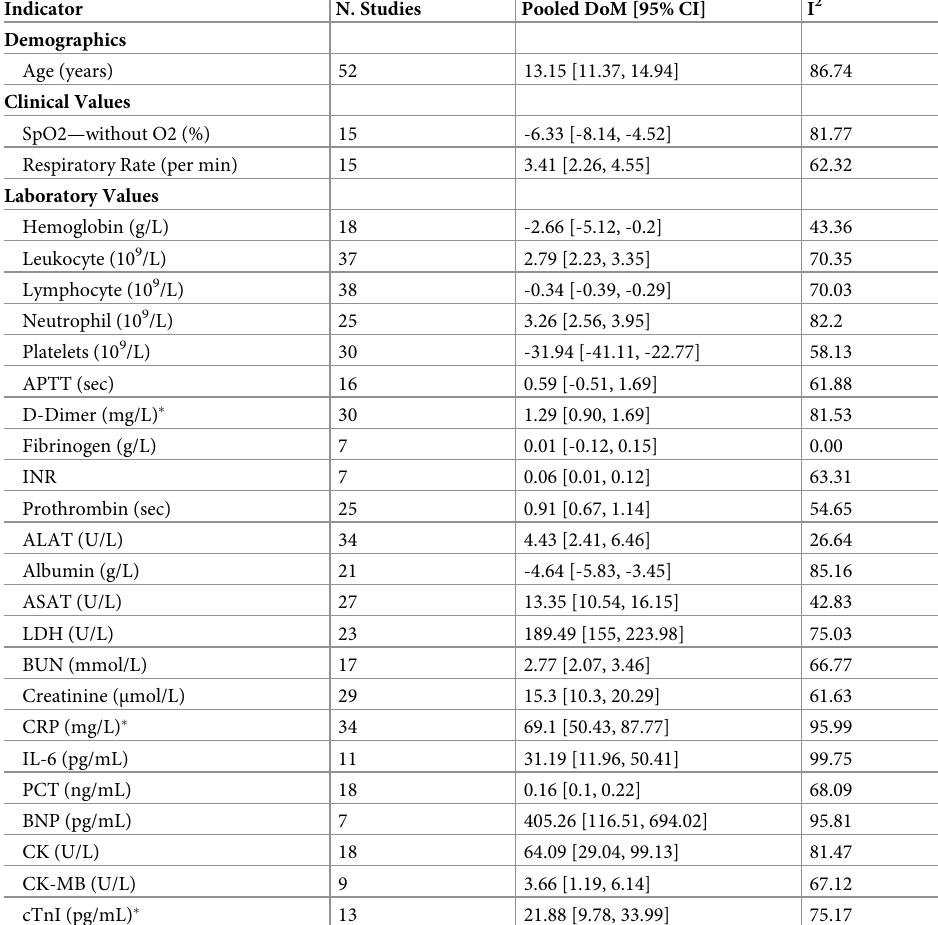
Table 2. Summary of the meta-analysis results for continuous indicators comparing those who died and those who survived. Indicator